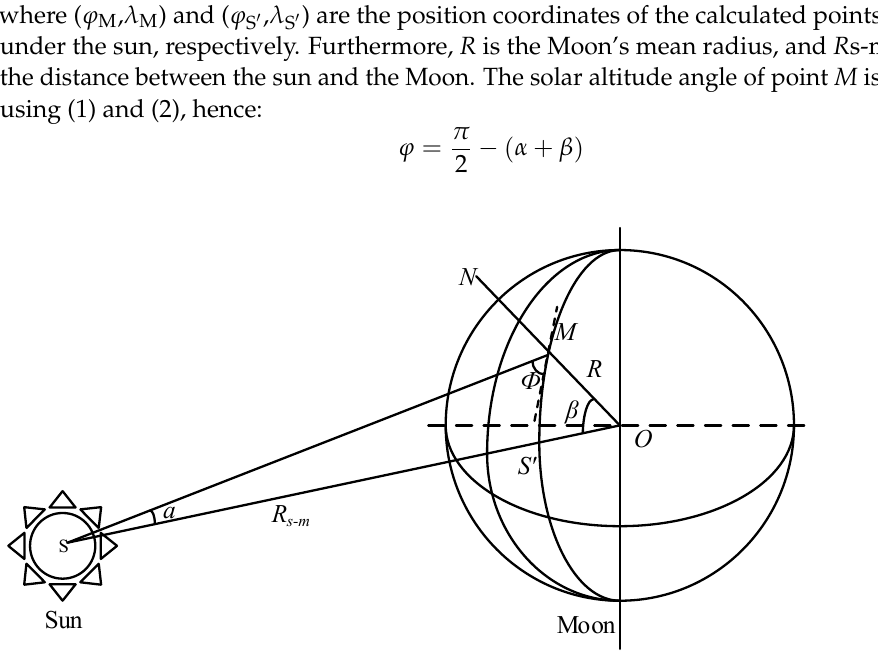
Figure 4. The calculation schematic diagram of the elevation angle of the sun.